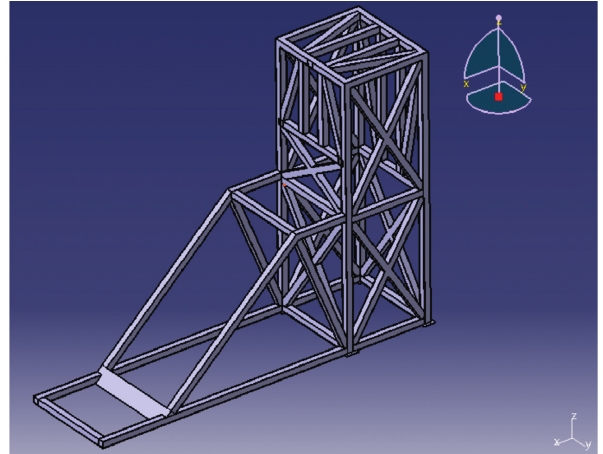
Figure 2: Final creep test rig design for actual 132kV composite